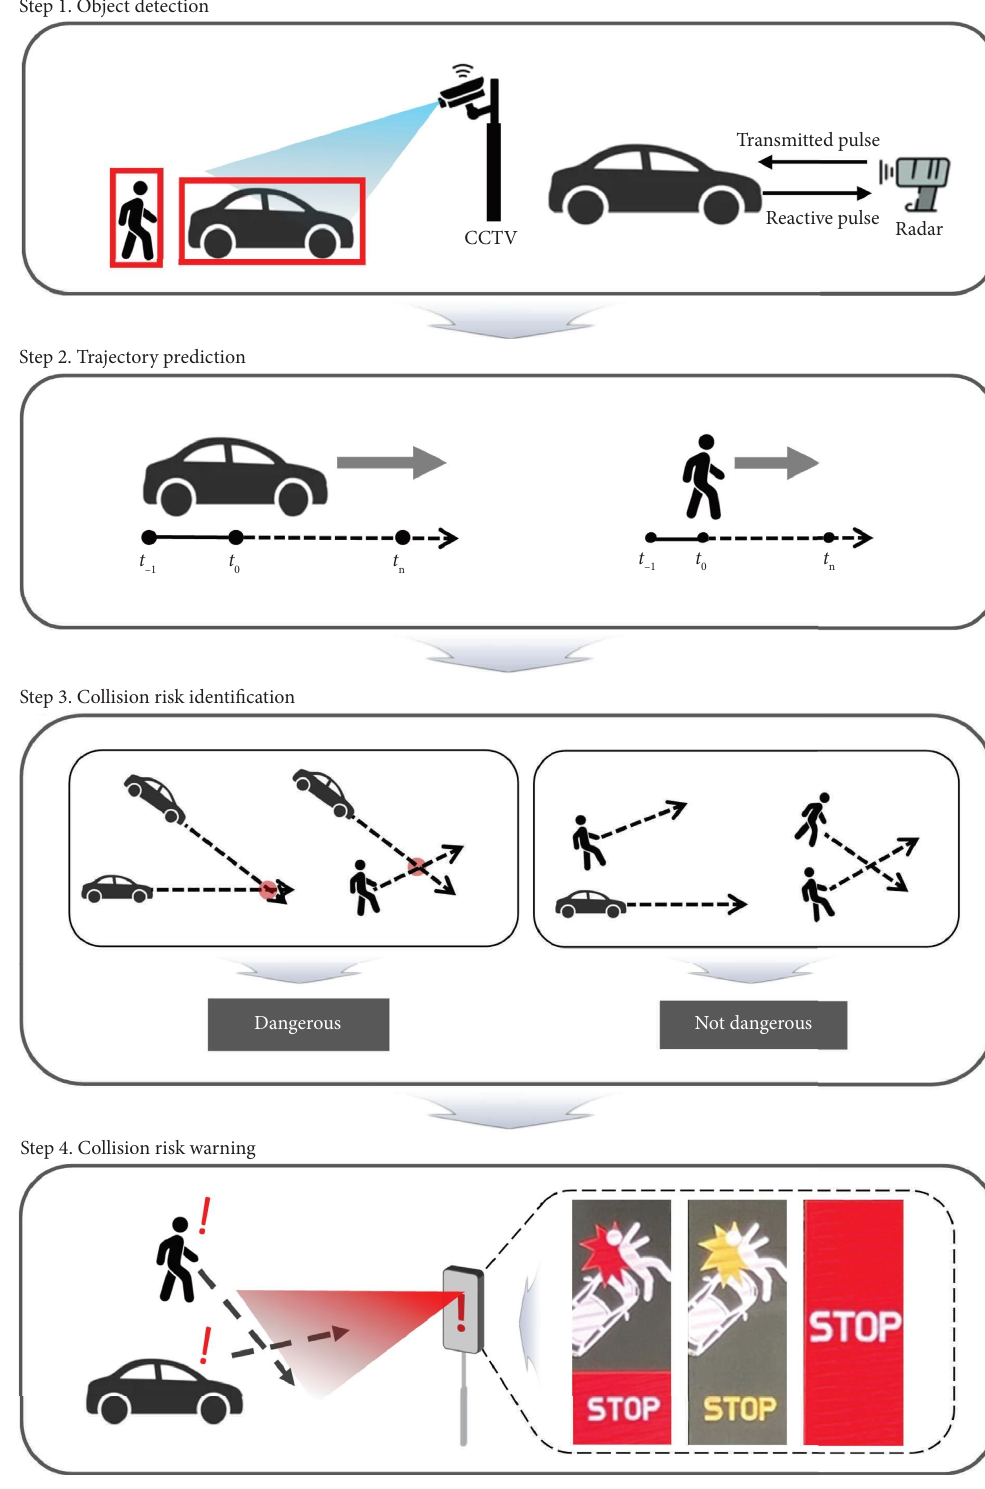
Figure 1: Overall structure of collision risk warning